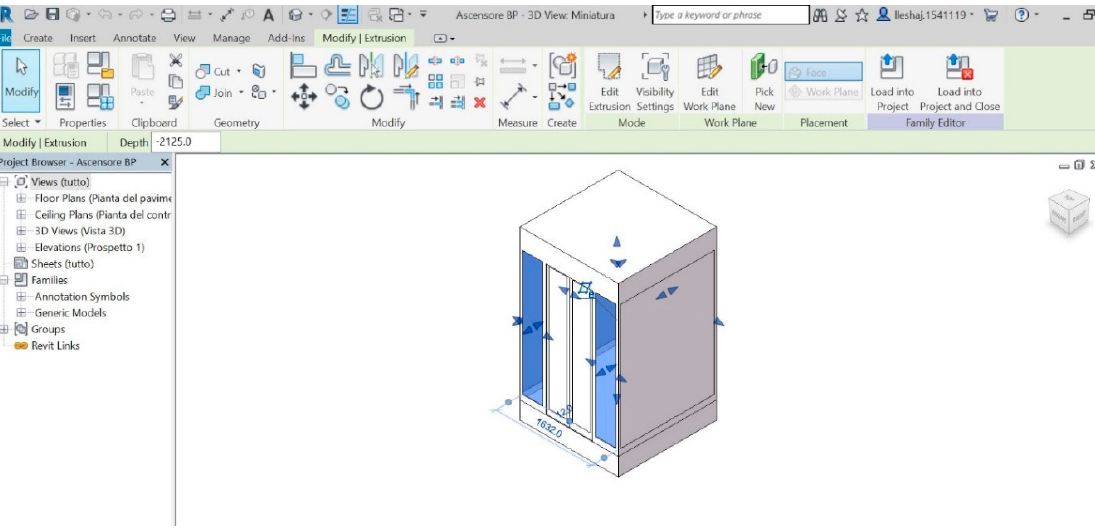
Figure 5. BIM model of the elevator.